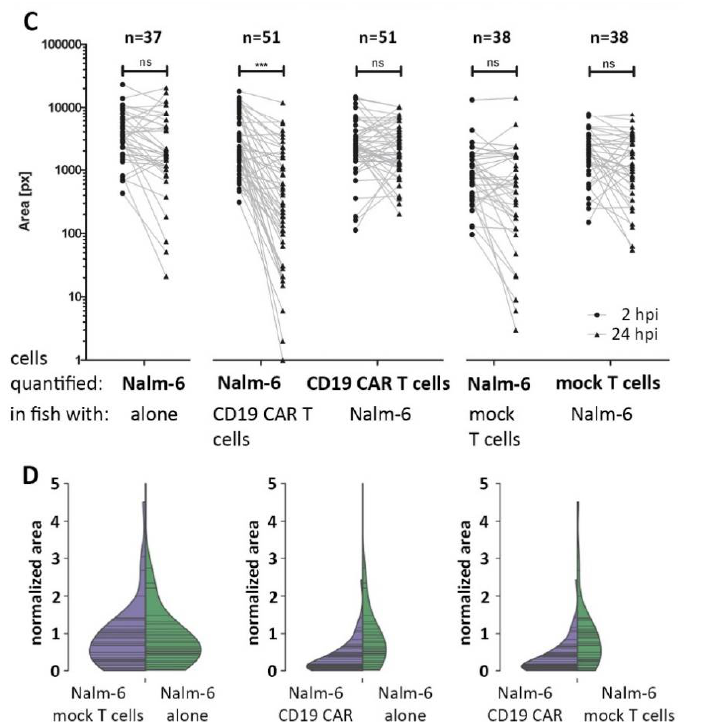
Figure 3. CAR T cell-mediated killing of Nalm-6 cells in zebrafish . Zebrafish embryos were injected with Nalm-6 cells (green) at approximately 48 hpf. Around 2 hours later, either mock T cells (without a CAR) (red cells in ( A )) or CD19 CAR T cells (red cells in ( B )) were injected and images were recorded within 2 hours and again at 24 hours post injection of T cells. ( C ) The numbers of Nalm-6 cells and T cells were quantified at 2 hpi and 24 hpi based on the fluorescent area covered by cells in the tail (red box in B) using Fiji. The two time points are connected by a line for each embryo. From left to right: Nalm-6 cells in zebrafish without any T cells; Nalm-6 cells (in zebrafish with CD19 CAR T cells), CD19 CAR T cells (in zebrafish with Nalm-6); Nalm-6 cells (in zebrafish with mock T cells), mock T cells (in zebrafish with Nalm-6) at 2 hpi and 24 hpi. ( D ) Violin plots normalized to the area covered by fluorescent cells at 2 hpi revealing the change in distribution at 24 hpi. Nalm-6 cells together with mock T cells or alone without T cells show similar distributions at 24 hpi, whereas Nalm-6 injected with CD19 CAR T cells show a reduction compared to Nalm-6 alone or Nalm-6 with mock T cells. Images were recorded on a Zeiss Axio Zoom.V16 fluorescence stereo zoom microscope and rendered with Adobe Photoshop CS6. Scale bar in ( A ) represents 1 mm.